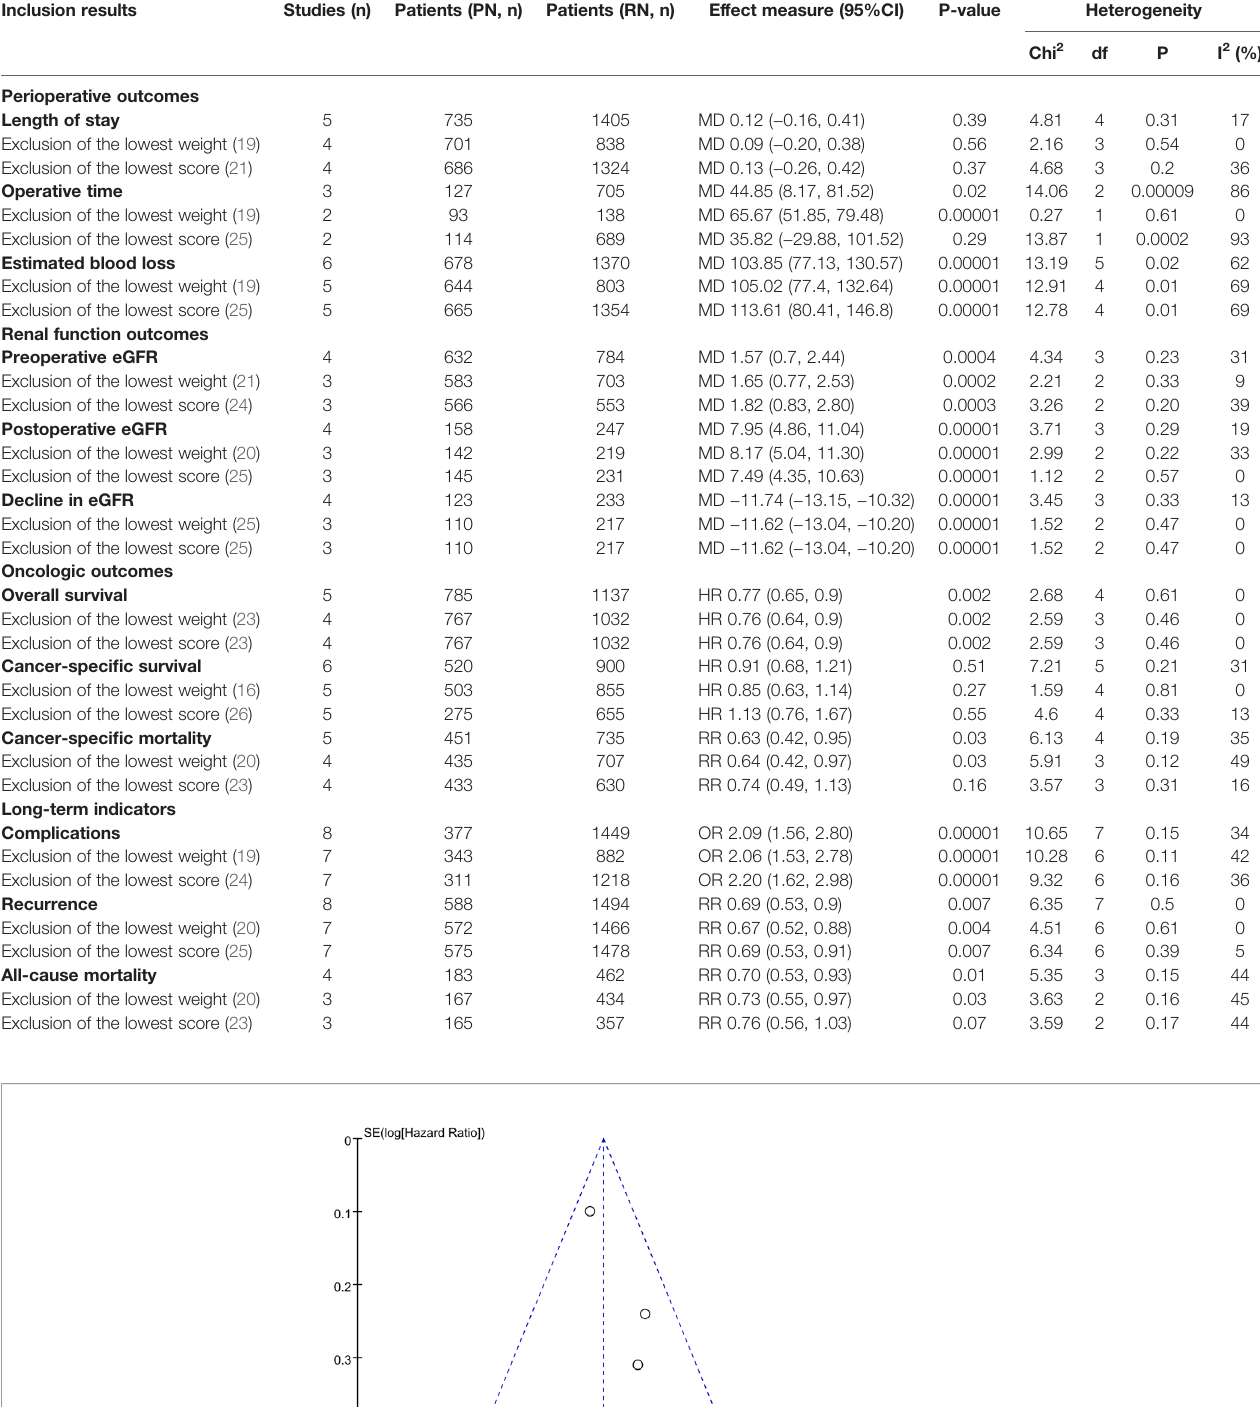
TABLE 2 | Results of sensitivity analysis about comparison of PN vs.